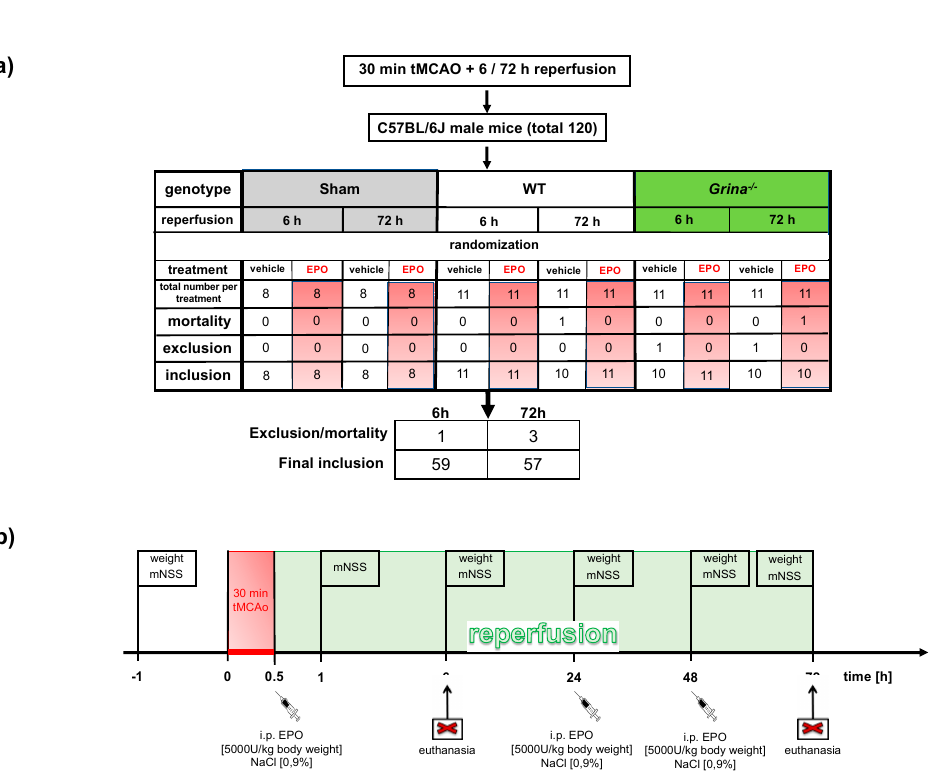
Figure 1. Protocol of randomized and blinded controlled trial (RCT) and study procedure ( a ) Table summarizing the number of total animals (120 mice) divided into the di ff erent experimental conditions. Mortality rate, exclusion per group and included animal for final analysis are given. Exclusion criteria: death during experiments, rCBF reduction of over 80% from baseline or no adequate increase to 60–70% of baseline after 5–10 min of reperfusion, brain haemorrhage, a weight loss of > 20% of baseline, missing neurological deficits (mNSS < 5) or no evidence of infarction in TTC-staining. ( b ) Weight measurement and neurological testing (mNSS) were performed at various time-points ( − 1, 1, 6, 24, 48 and 72 h after stroke or sham surgery). Mice were subjected to 30 min of tMCAo or sham surgery followed by 6 or 72 h of reperfusion. EPO or saline was injected directly after surgery, 24 and 48 h after tMCAo / sham surgery. GRINA-deficient mice exhibited neither a spontaneous phenotype nor haematological di ff erences compared to wildtype mice (Table 1).